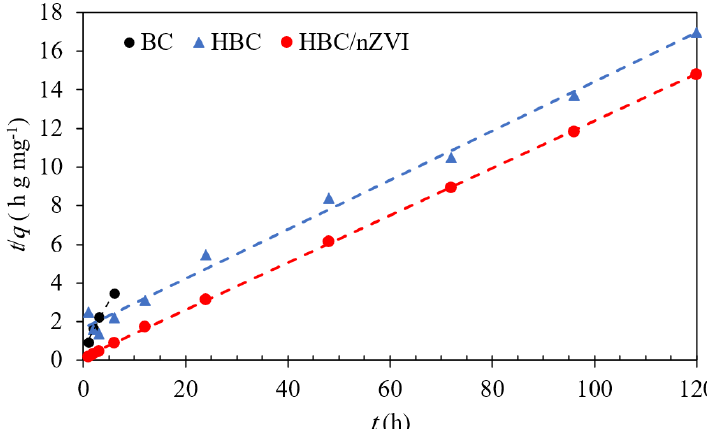
Figure 7. Pseudo-second-order kinetic models for aqueous Cr(VI) removal using BC, HBC, and HBC/nZVI. Dashed lines represent fitted pseudo-second-order models, and the markers represent experimental data points. Experimental conditions: initial Cr(V) concentration = 10 mg L − 1 , pH = 4.0, adsorbent dose = 1.5 g L − 1 . Table 1. Pseudo-second-order kinetic model characteristics for the removal of Cr(VI) using BC,